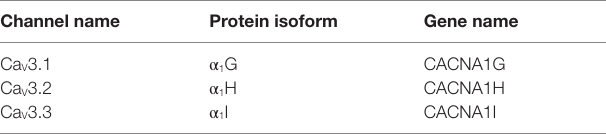
TABLe 1 | Nomenclature of T-type calcium